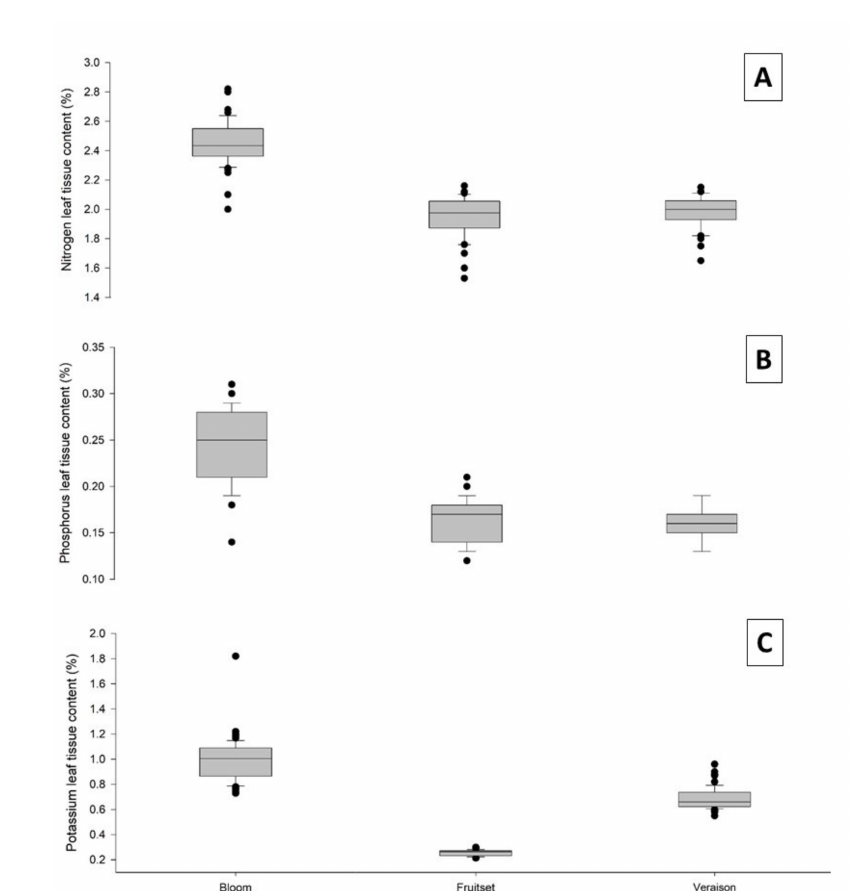
Figure 2. Variation of tissue nutrient content for nitrogen ( A ), phosphorous ( B ) and potassium ( C ) in fully mature leaf samples (combined data from 2019 and 2020, n = 56). Shown are Median, 25 and 75 percentiles as well as outliers. Samples taken during bloom show the highest variability, compared to samples taken at fruit set or v é